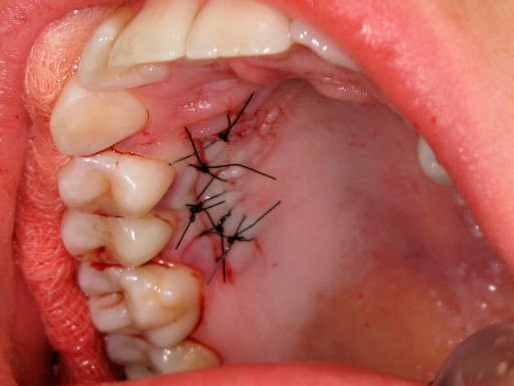
Figure 3. The palatal donor site after harvesting the connective tissue graft.